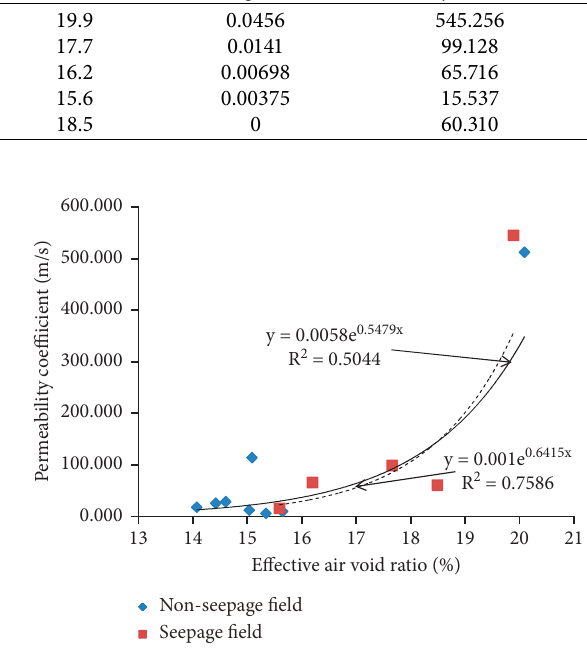
Figure 17: Relationship between effective void ratio and non- Darcy flow permeability